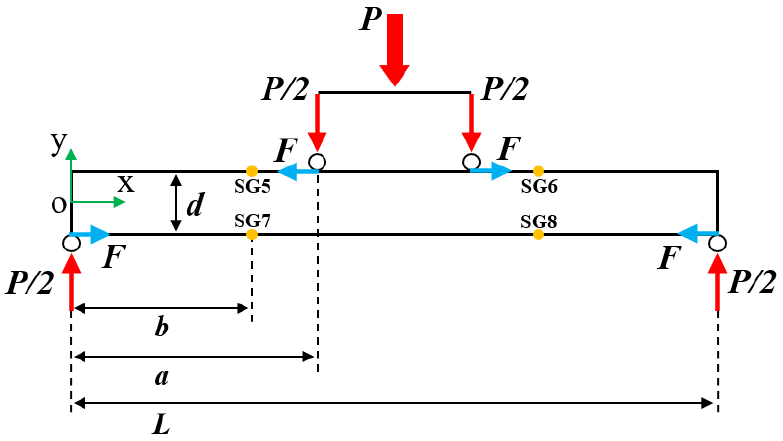
Figure 26. The loading schematic of the four-point bending test.